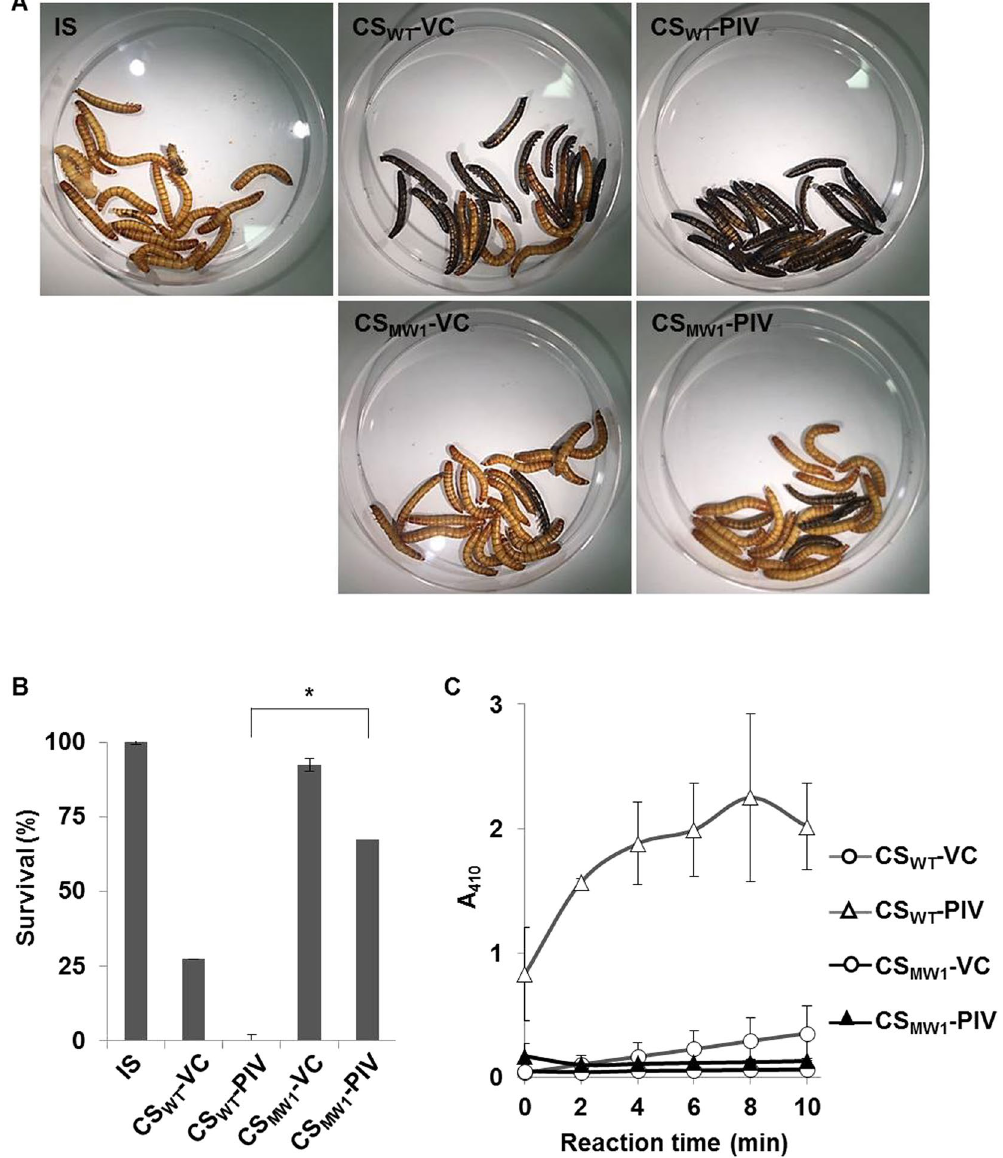
Figure 1. Reduced activity of PIV expressed in QS mutant. The CSs prepared from the PIV-overexpressing (pSP301-harboring) PAO1 (CS WT -PIV) or MW1 (CS MW1 -PIV) were injected into T . moliter larvae, and the death with melanization was observed for 4 days ( A ) and quantified ( B ). The CSs were concentrated 10 times before injection and 5 μ l of CS was injected. Insect saline (IS) was injected for injection control and CSs prepared from pJN105-harboring PAO1 or MW1 (CS WT -VC) or MW1 (CS MW1 -VC) were injected for vector control (VC). * p < 0.01. ( C ), the activity of PIV in the CSs was measured by chromogenic substance. Absorbance at 410 nm (A 410 ) was measured every 2 min for 10 min at 37